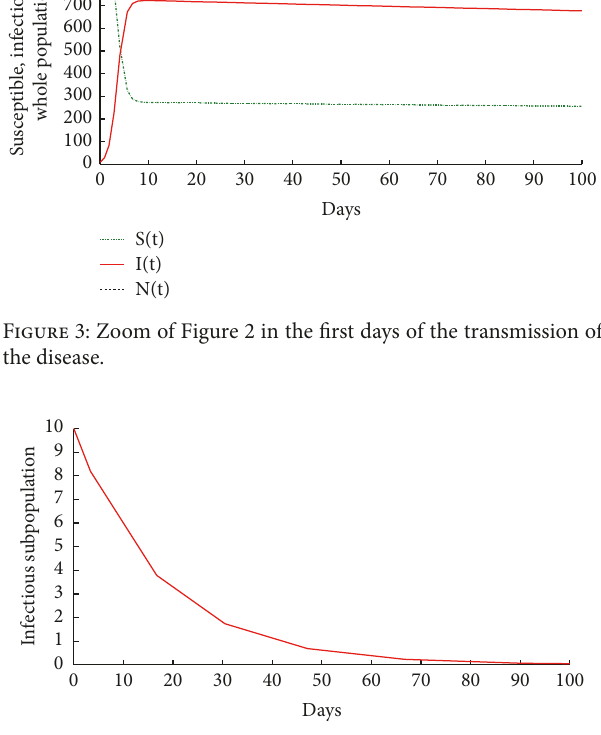
Figure 4: Infectious subpopulation in the SISV model without vac- cination when the basic reproduction number of its corresponding normalized SISV model is 𝑅 0 = 0.878